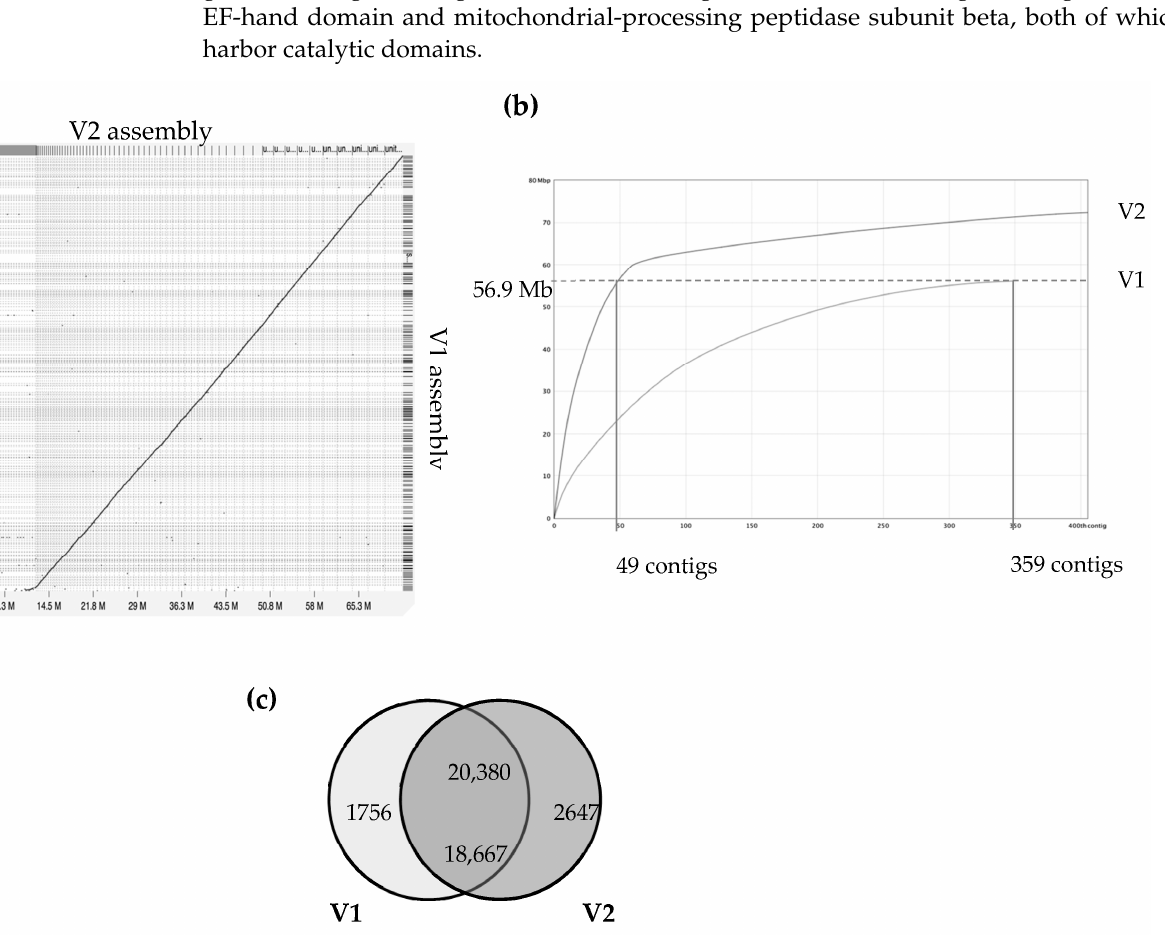
Figure 1. Comparison of version 1 and version 2 of A. euteiches genome assembly (ATCC201684 strain). A previous study using Illumina/454 technologies allowed the V1 assembly of the A. euteiches genome to be obtained [41]. This study provides the V2 assembly, obtained using long-read PacBio technology. ( a ) Dot-plot of pairwise whole-genome alignment of V1 and V2 assemblies. Note the additional sequence consisting of smaller contigs in V2 as compared to the V1 assembly. ( b ) Plot describing distribution of contigs by length for V1 and V2 assemblies. The 49 largest contigs of V2 cover the full size of the V1 genome. Additional contigs are present in V2. ( c ) Venn diagram of pairwise protein comparison of V1 and V2 (% ident > 75%, coverage > 75%). Shared part represents number of pairwise hits from V2 (upper number) and V1 (lower